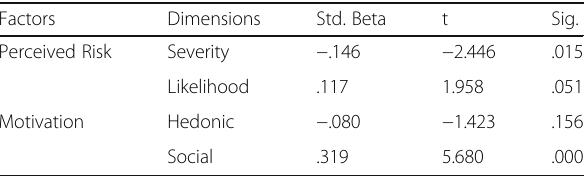
Table 5 Regression analysis of perceived risk and motivation